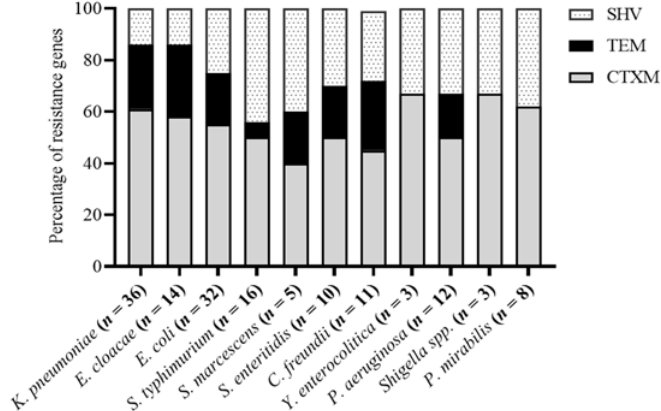
Figure 2. Genetic distribution of ESBL-encoding genes in the isolates ( n = 150).